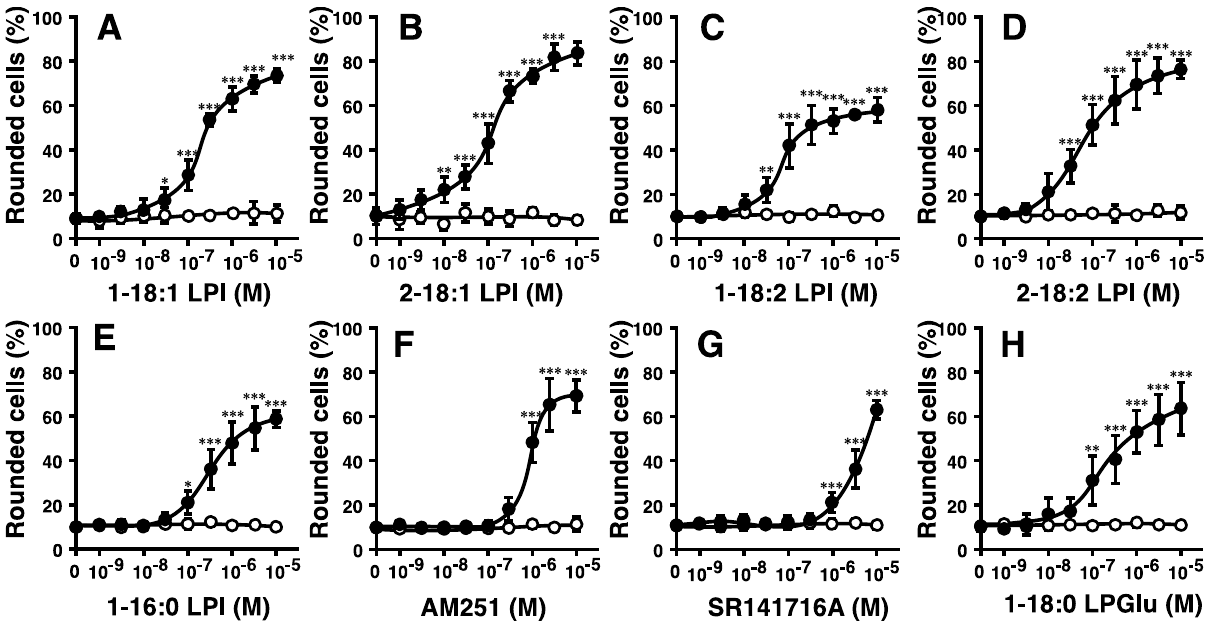
Figure 2. Effects of various species of LPI and related molecules on cell morphology in HEK293 cells stably expressing GPR55. Vector-transfected cells (open circle) or GPR55-expressing cells (closed circle) were challenged with various concentrations of 1-oleoyl LPI ( A ), 2-oleoyl LPI ( B ), 1-linoleoyl LPI ( C ), 2-linoleoyl LPI ( D ), 1-palmitoyl LPI ( E ), AM251 ( F ), SR141716A ( G ), or 1-stearoyl LPGlu ( H ) at 37 ◦ C for 5 min. After treatment, images of cells were obtained, and cell rounding was analyzed. Statistical analyses were performed with one-way analysis of variance (ANOVA), followed by Dunnett’s multiple comparison test. The values are means ± SDs of five determinations. * p < 0.05, ** p < 0.01, and *** p < 0.001 versus values with vehicle alone ( n =